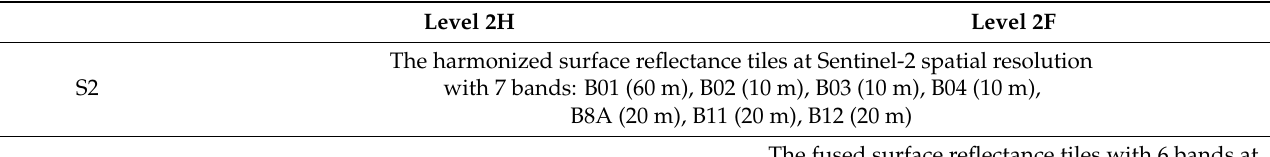
The fused surface reflectance tiles with 6 bands at The harmonized surface reflectance tiles with 7 Sentinel-2 resolution bands at Landsat-8 spatial resolution (B01, B02, B03, B04, B8A (L05), B11 (L06), B12 (L07) with 1 band at Landsat-8 resolution B01 (30 m) The surface reflectance tiles at Sentinel-2 spatial resolution with 4 channels B05 (20 m), B06 (20 m), B07 (20 m), NATIVES2 B08 (10 m) NATIVELS8 The panchromatic surface reflectance tile (15 m) and the 2 emissive bands at 30 m resolution (L10 &